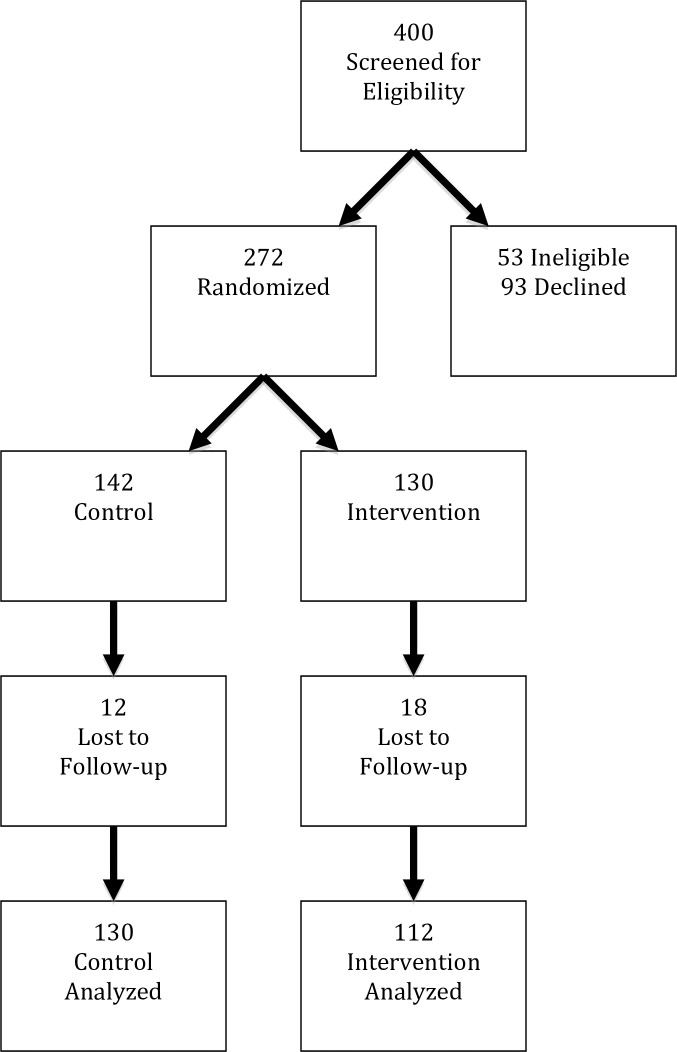
Flow diagram of phases of enrollment, allocation, follow-up and analysis.